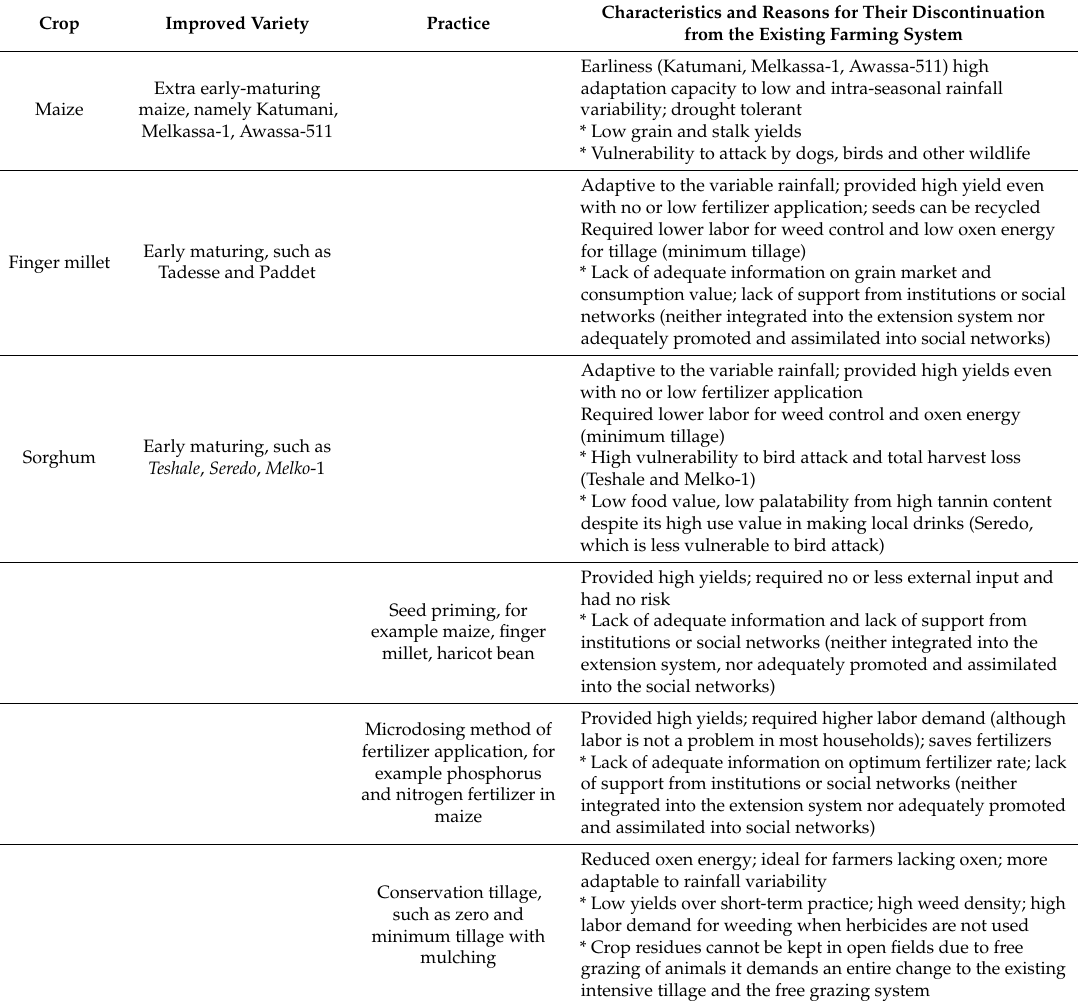
Table 2. Discontinued improved crop varieties and agricultural practices, key characteristics, and reasons for their discontinuation from the agricultural